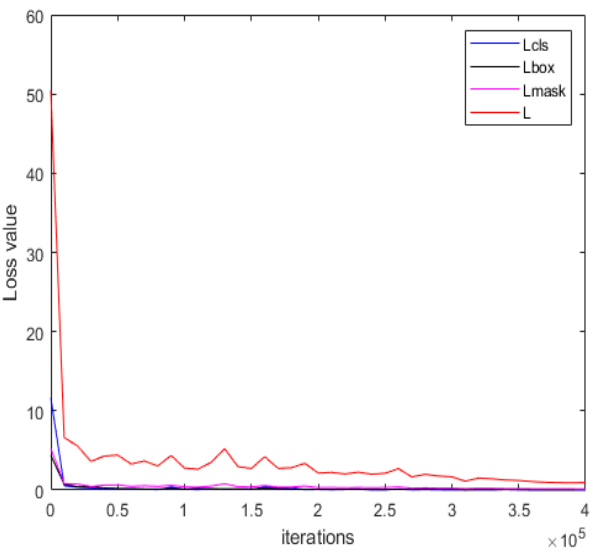
Figure 8. Loss value corresponding to different iterations .